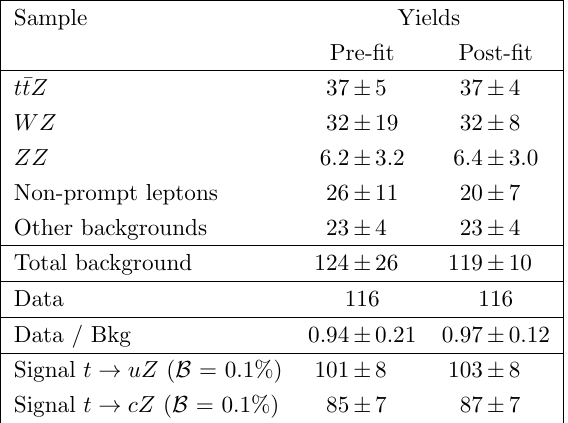
Table 8 . Expected number of background events, number of selected data events, and number of signal events (arbitrarily normalized to a branching ratio of B ( t ! qZ ) = 0.1%) in the signal region before and after the combined (cid:12)t under the background-only hypothesis. The uncertain- ties shown include all of the systematic uncertainties described in section 7. The entry labelled \other backgrounds" includes all remaining backgrounds described in section 3 and in table 2. The uncertainties in the post-(cid:12)t yields are calculated using the full correlation matrix from the (cid:12)t.